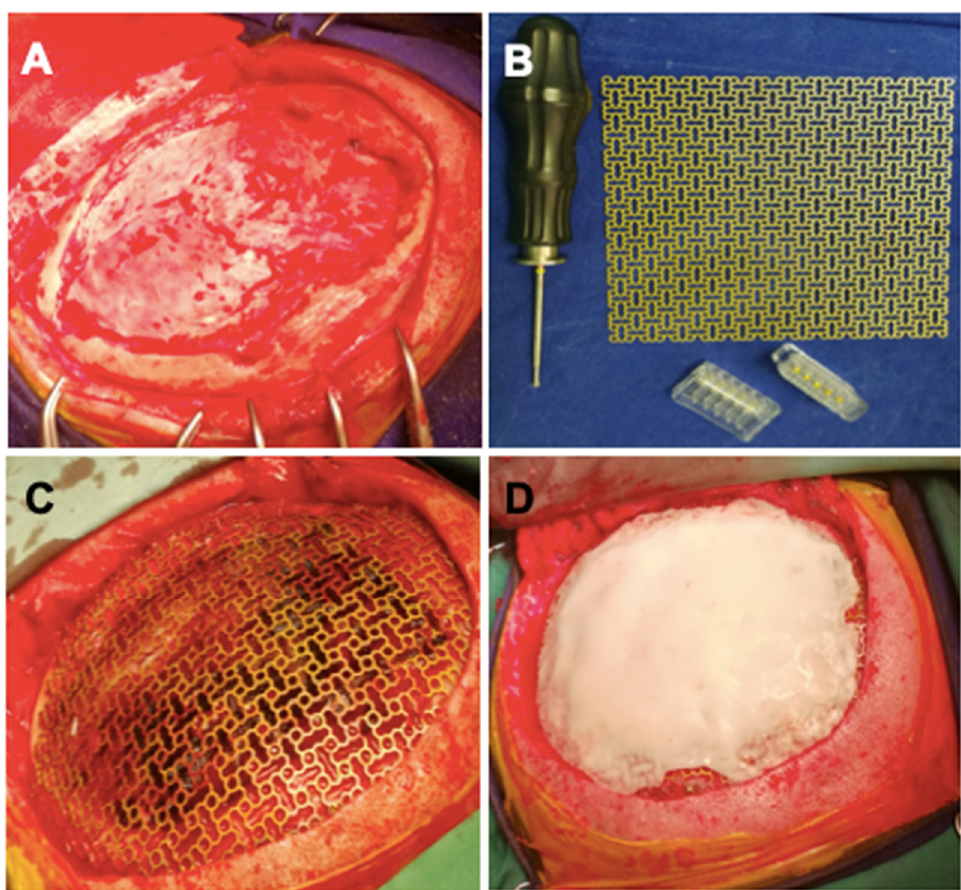
Figure 2. ( A ) Left frontoparietal craniotomy. ( B ) Titanium mesh with titanium monoaxial screws clamping system. ( C ) The aspect of applied titanium mesh. ( D ) PMMA cementation over titanium mesh.